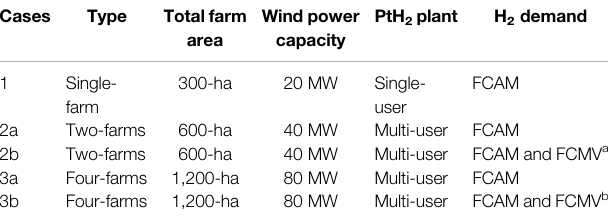
a 8.86 Lofdiesel-equivalentperdaytofueltwofuelcellminivans(FCMV);FCAM – fuelcell agricultural machinery. b 17.72 L of diesel-equivalent per day to fuel four FCMV.